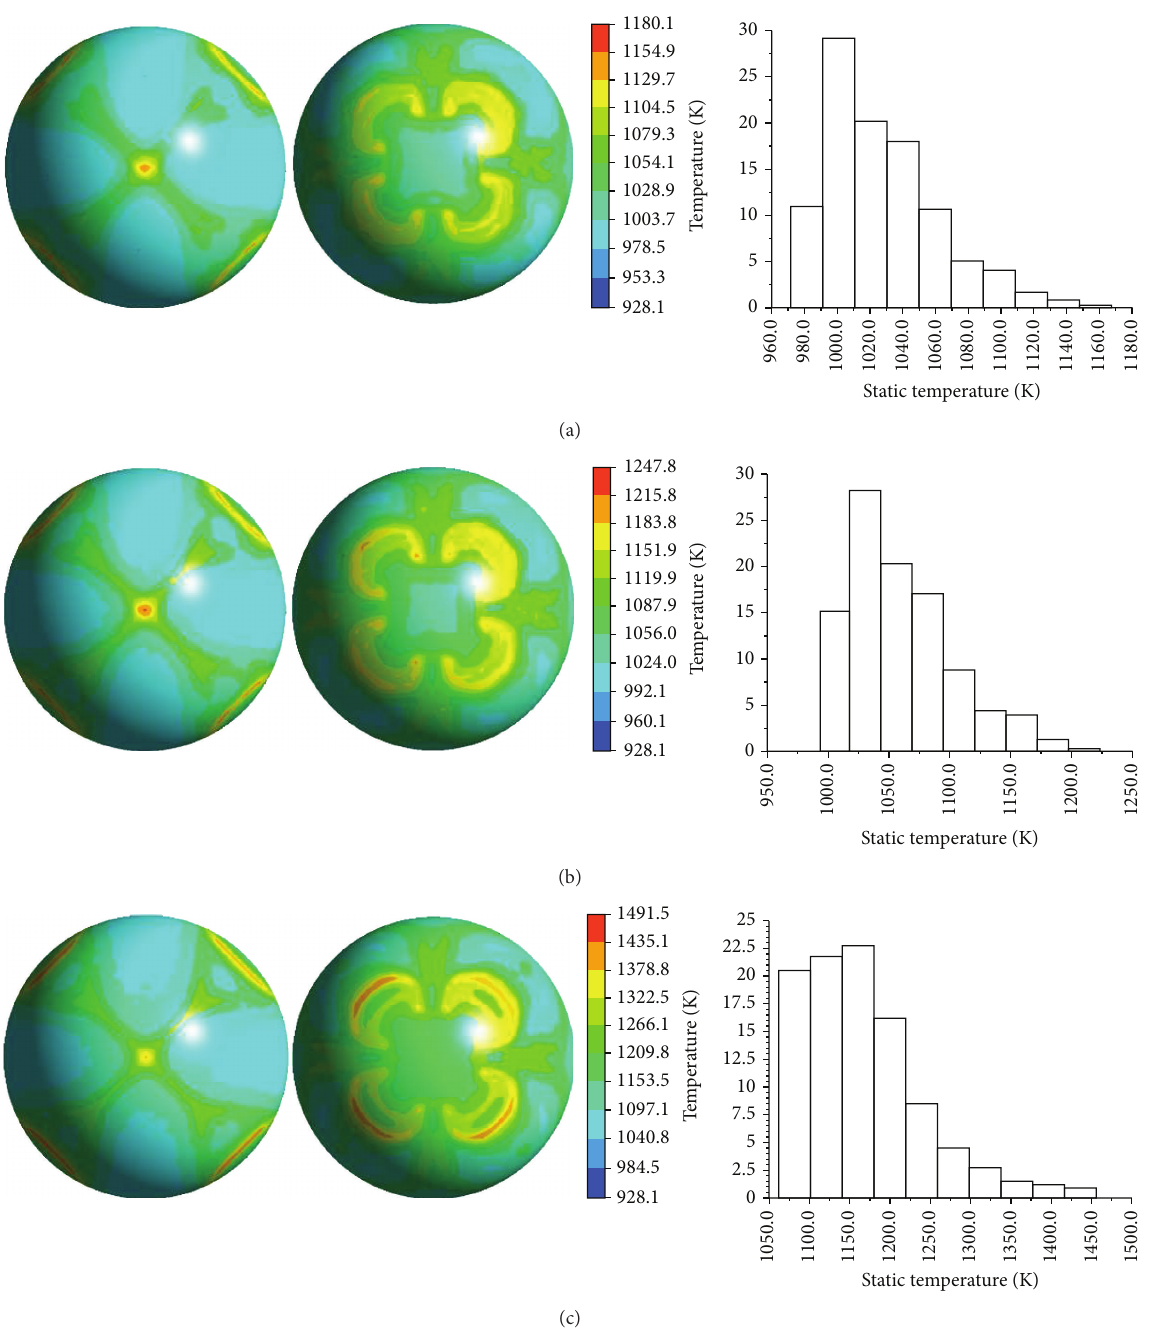
Figure 10: Pebble temperature distribution of BCC model of Cases 3a, 3b, and 3c (view from inlet (left), outlet (middle)) and temperature distribution